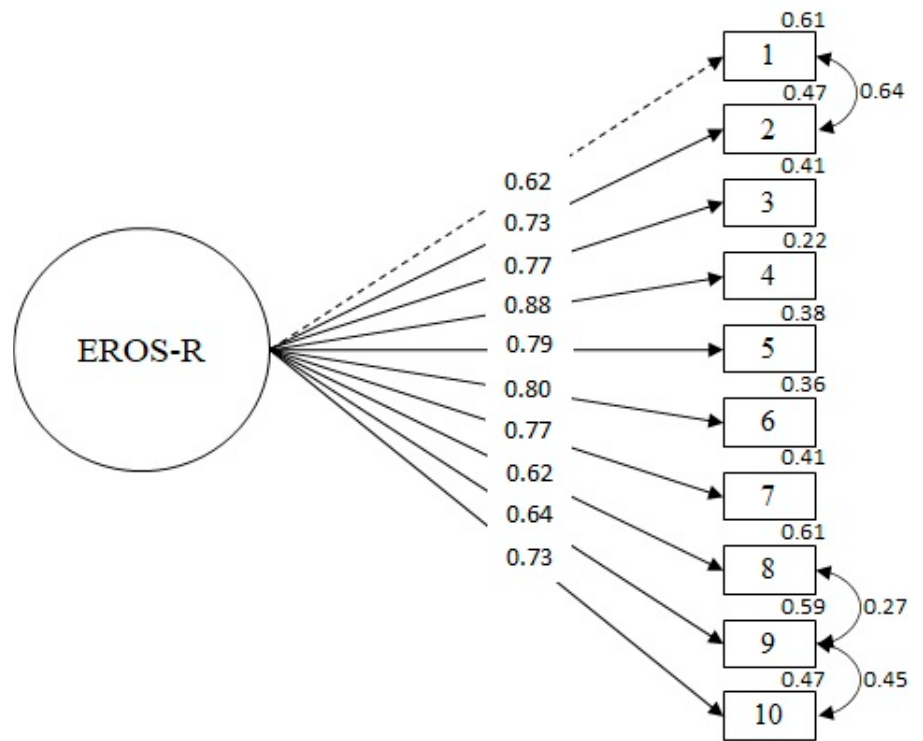
Figure 1. Confirmatory factor analysis of the scale. Note. All factorial weights are statistically sig- nificant ( p < 0.01). significant ( p <